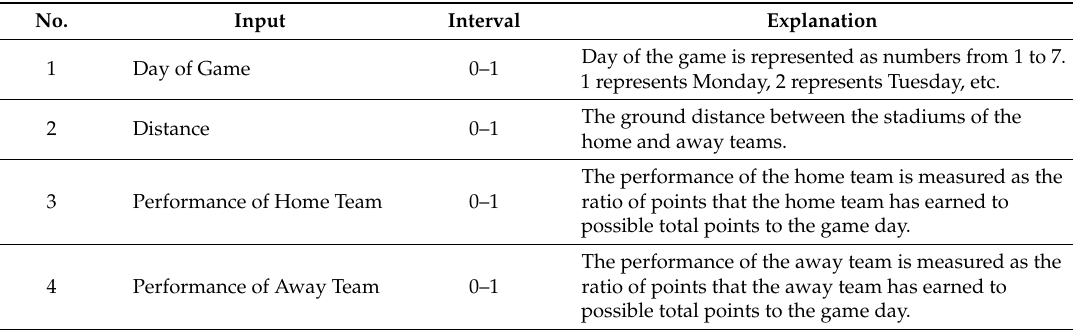
Table 1. Input parameters and their